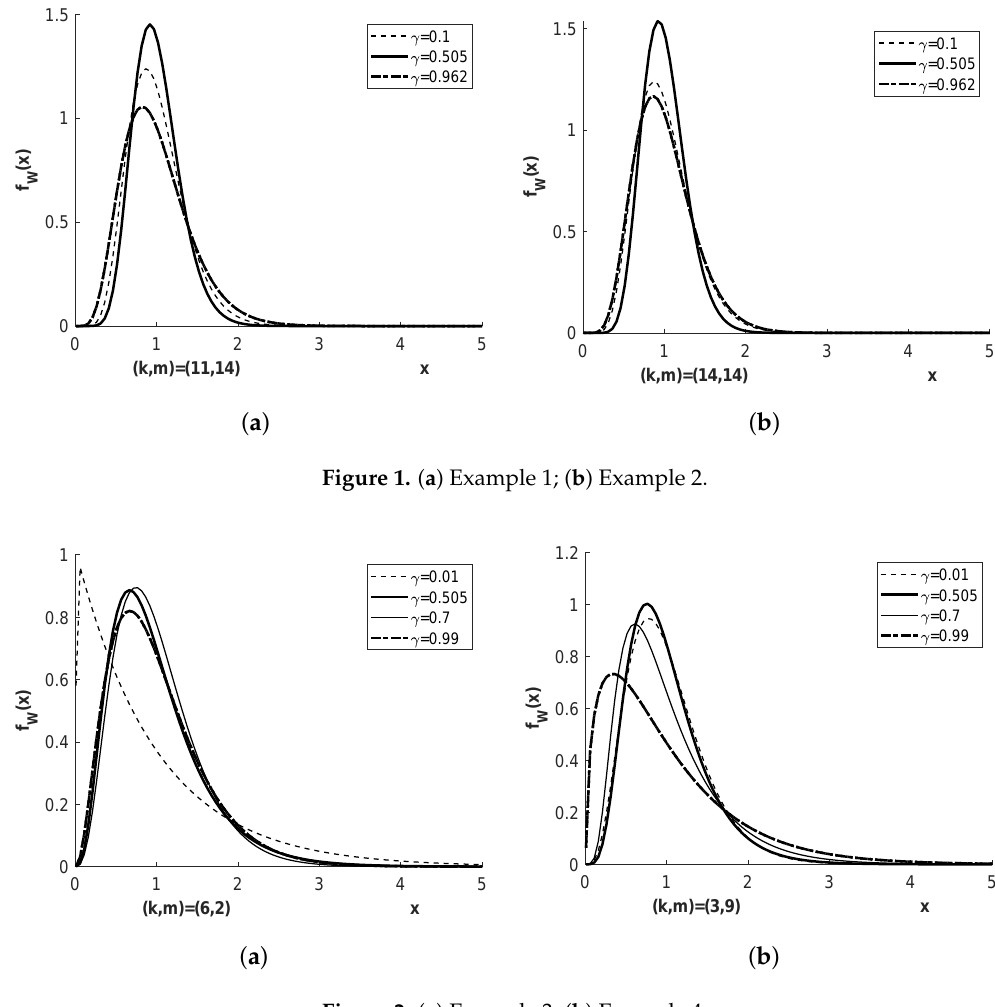
Figure 2. ( a ) Example 3; ( b ) Example